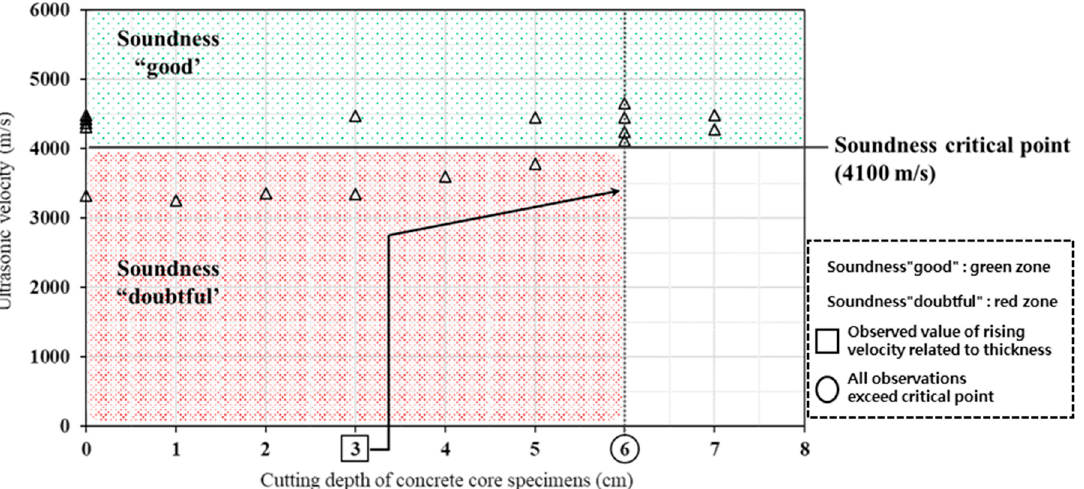
Figure 9. Ultrasonic velocity result according to the cutting thickness of the core specimens (Spalling severity with middle and lower section).